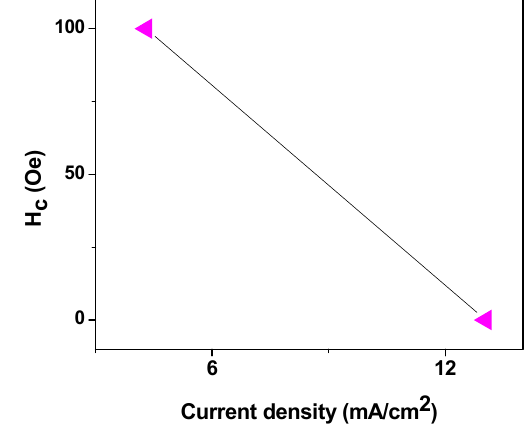
Fig. 3. Magnetization curve graph of 1 and 3 samples , magnetite nanoparticles produced by electrochemical method in current density and in presence of NaOH.